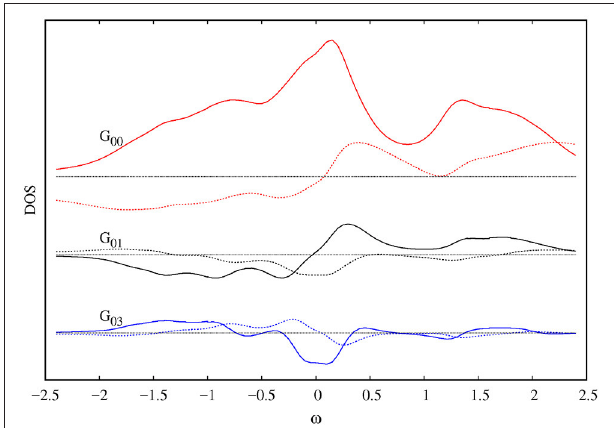
FIGURE 4 | Imaginary (continuous lines) and real (dotted lines) Green’s functions for the doped Hubbard model ( µ 0.3) on the square lattice with = − t ′ 0.05 and U 2 calculated using c4-DMFT, arbitrary units. The red = − = continuous curve corresponds to the density of states. The Fermi energy lies at ω 0 and the horizontal lines are at =